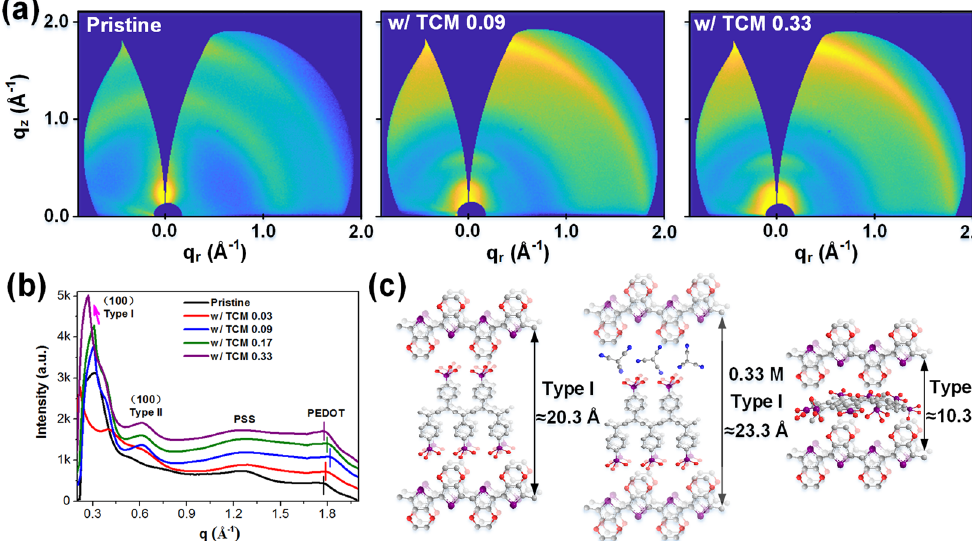
Fig. 5 Crystalline structure of PEDOT:PSS hybrid fi lm. a Typical 2D GIWAXS patterns of PEDOT:PSS/EMIM:TCM hybrid fi lms. b 1D GIWAXS scattering pro fi les integrated along cake cuts of the 2D patterns. c Schematic diagram of the lamellar stacking structures of PEDOT:PSS, extracted from the GIWAXS data